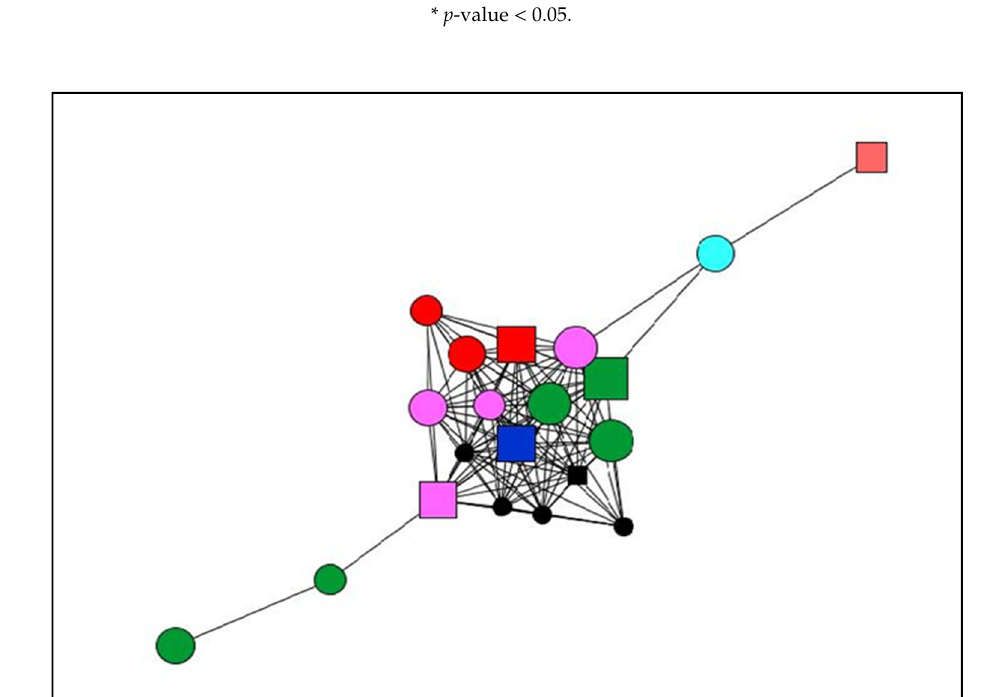
Figure 2. Graph Case 1. Woman (40 years old), living with chronic pain for 14 years.